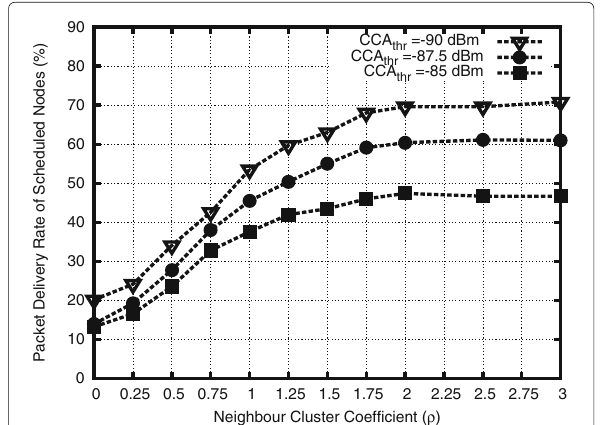
Fig. 7 Packet delivery rate of the scheduled nodes with K = 100, M = 50, and different values of CCA